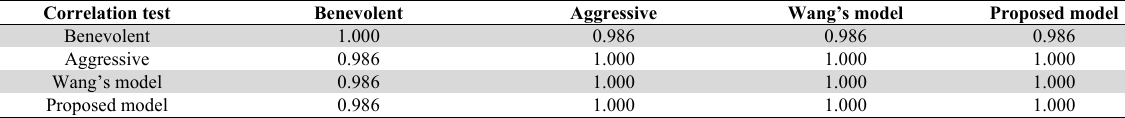
Spearman’s rank correlation test for six nursing homes